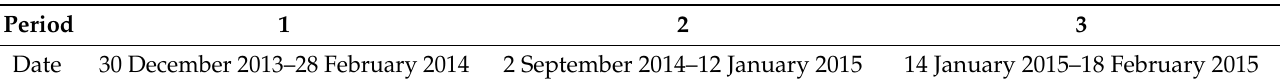
Table 1. The three periods with available Numerical Weather Prediction (NWP) and observational data. Period